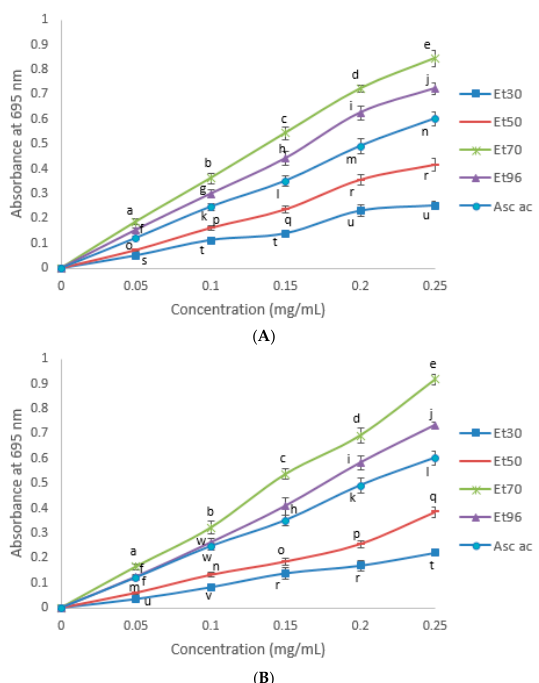
Figure 4. Transition metal reducing power (abs at 695 nm) of the ascorbic acid and the seed extracts of FSV ( A ) and FWV ( B ) at different ethanol concentrations in the extract solutions. Means not bearing a same letter are significantly different ( p < 0.05). Asc ac = Ascorbic acid. Treatments: Et30 = extract with 30% ethanol; Et50 = extract with 50% ethanol; Et70 = extract with 70%